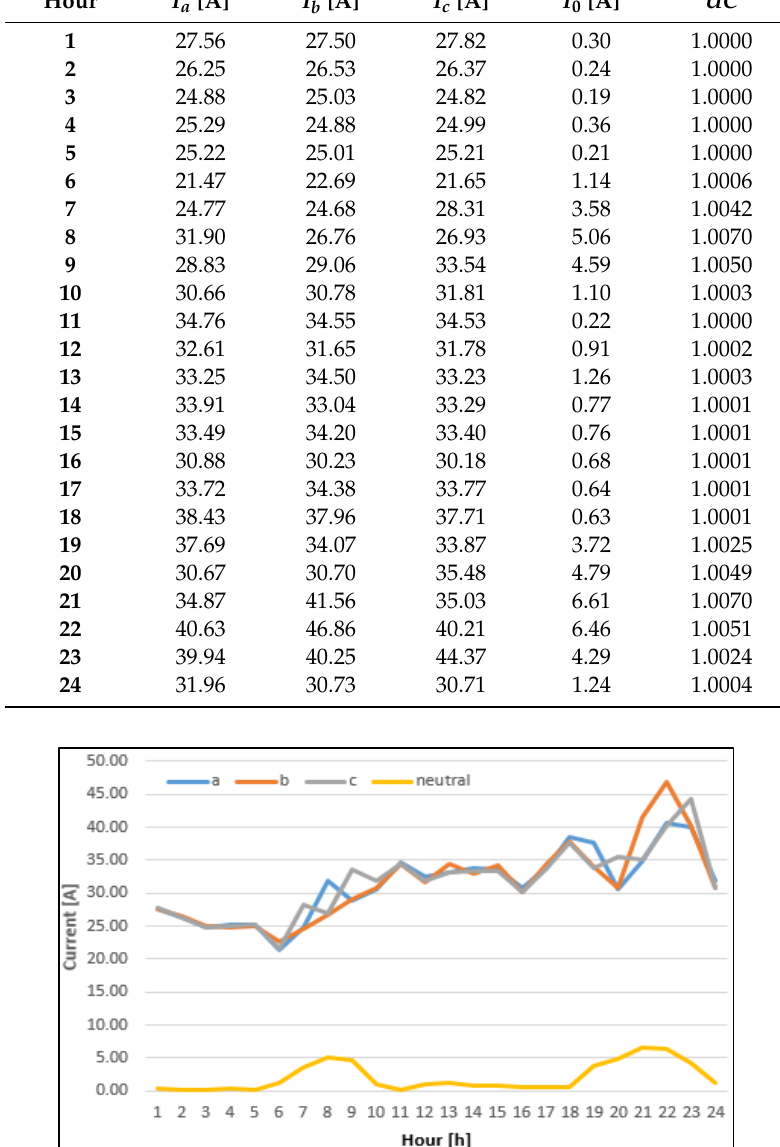
Figure 11. The currents in the conductors of the first branch, SP-Pillar 8, with the proposed algorithm.